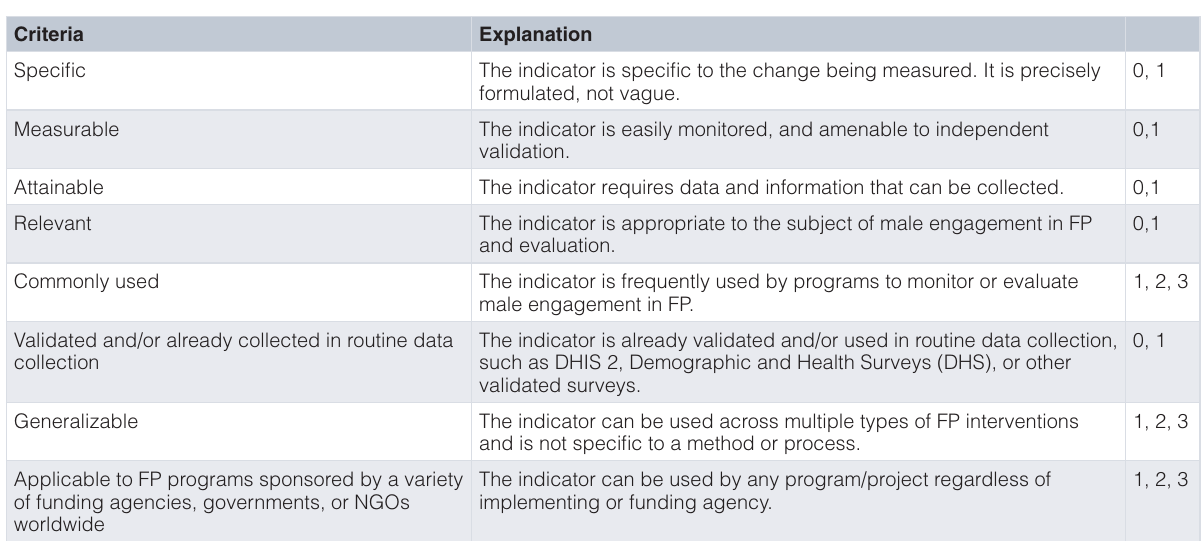
Table 1. Indicator criteria, definitions and